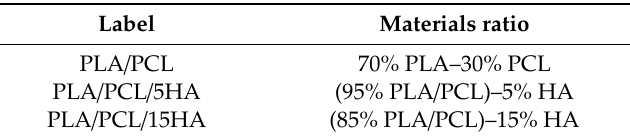
Figure 1. Wellzoom Desktop Extruder Line II. Table 2. Controlled extrusion parameters of the desktop single-screw extruder.